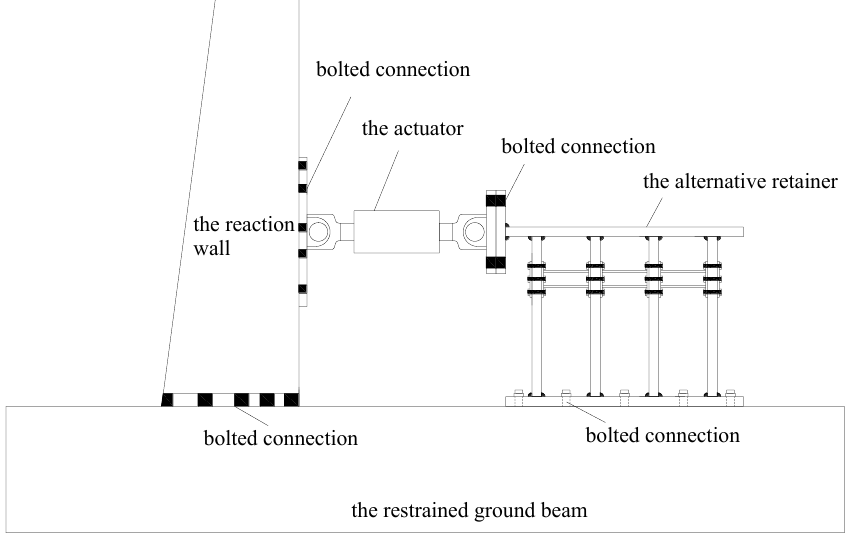
Figure 5. Test setup.